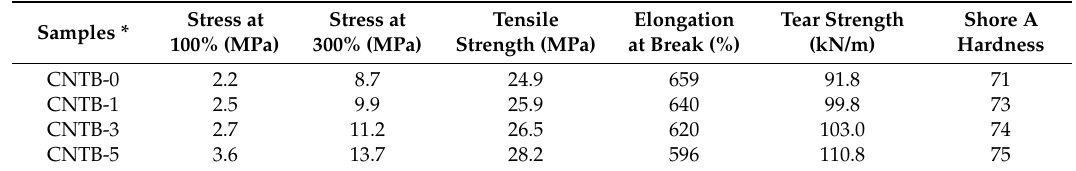
Table 6. Mechanical properties of CNTB (carbon nanotube bundles) reinforced natural rubber composites (Modified). Reproduced with permission from Wiley